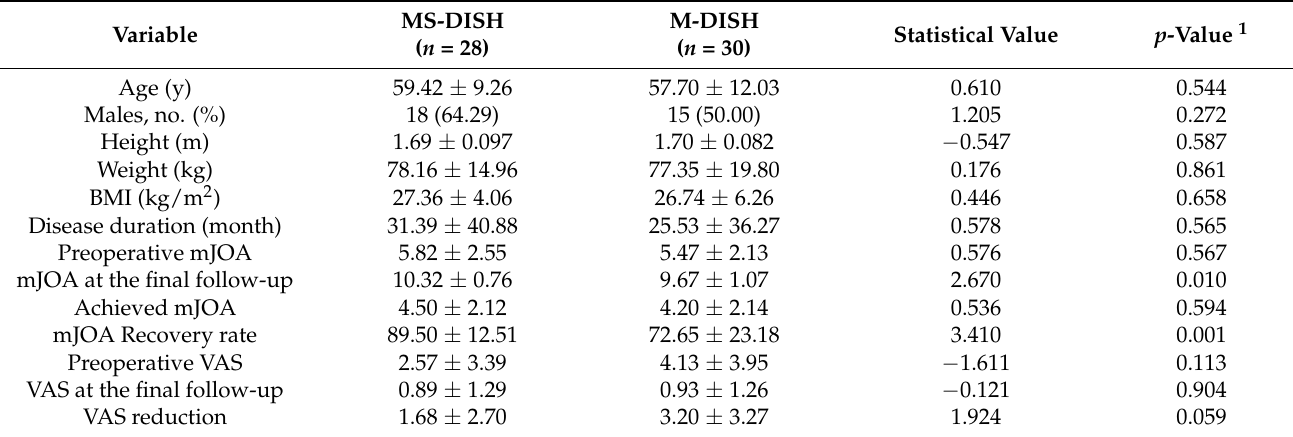
Table 6. Functional outcomes between the M-DISH and MS-DISH group. MS-DISH group contains 18 males while M-DISH group contains 15